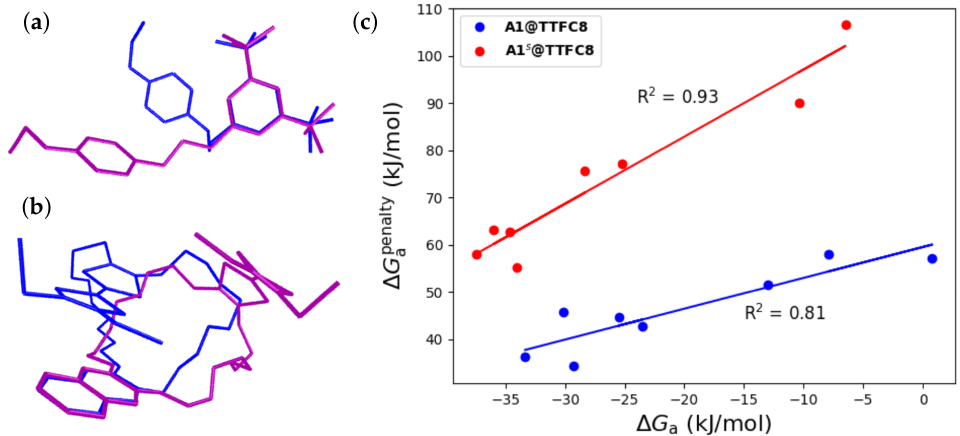
Figure 3. Illustration of the structural penalty, using the example of ( a ) A1 without a counterion and ( b ) TTFC8 ; the structures in blue correspond to the free structure, while the purple ones represent the structure in the supramolecule. ( c ) Plot of ∆ G apenalty vs. ∆ G a for A1@TTFC8 (blue) and A1 s @TTFC8 (red). The coefficients of determination are given for convenience.